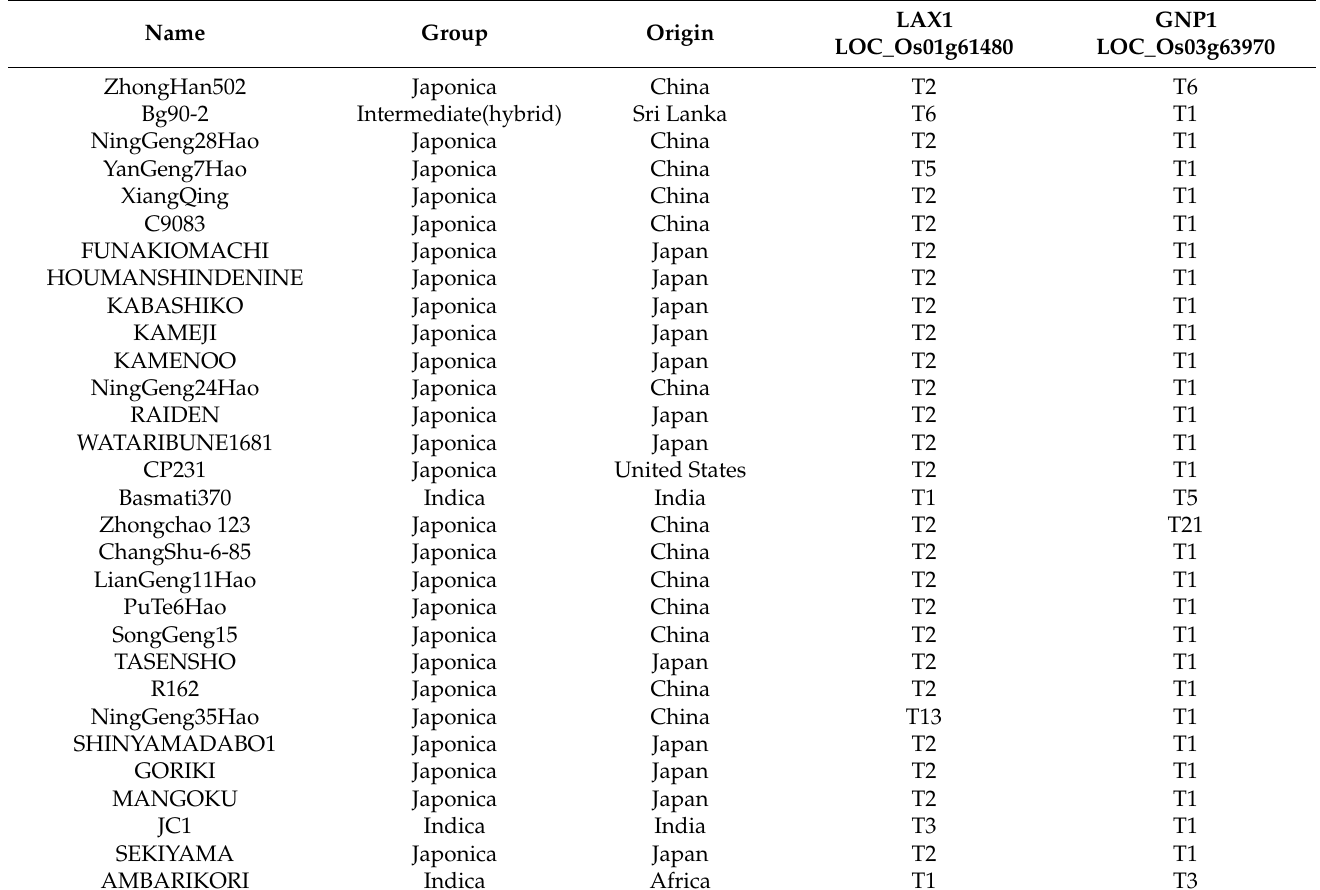
Table 4. Genotypes of over 200 GNPP rice varieties in MBK